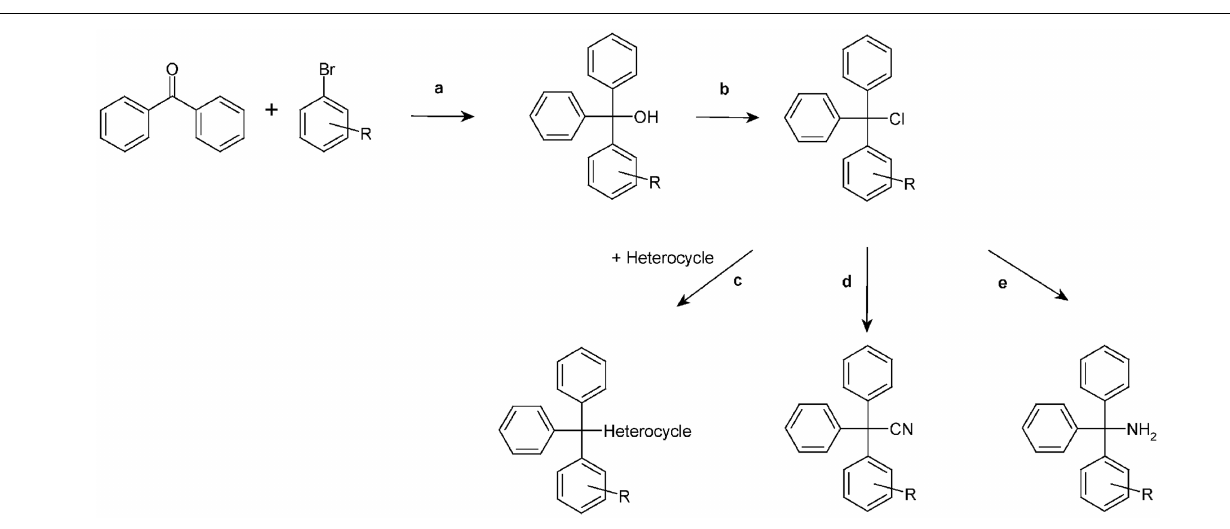
FIGURE 2 | (A) Dose-concentration curve for Cx50 inhibition by clotrimazole. (B) Connexin-selectivity profile of clotrimazole (10 μ M). Shown is percentage of current inhibition (mean ± SEM).